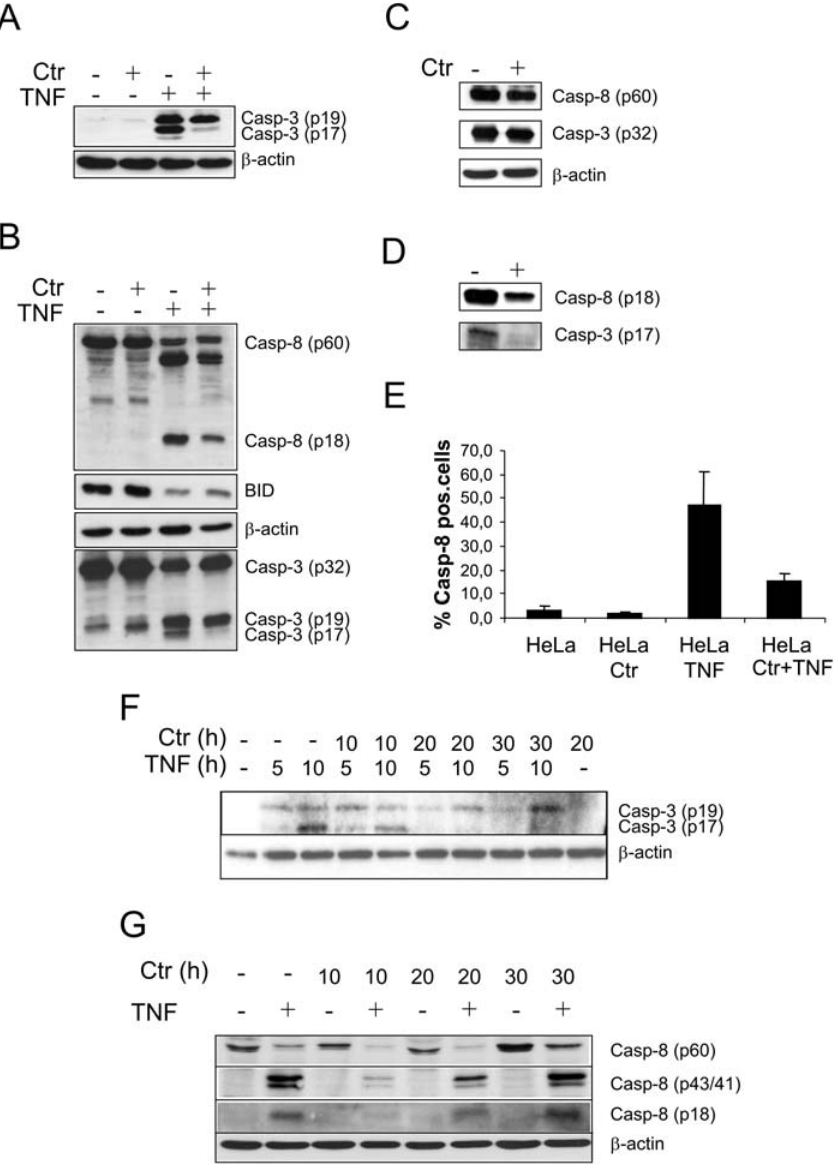
Figure 1. Reduced Activation of Caspase-3 in Infected